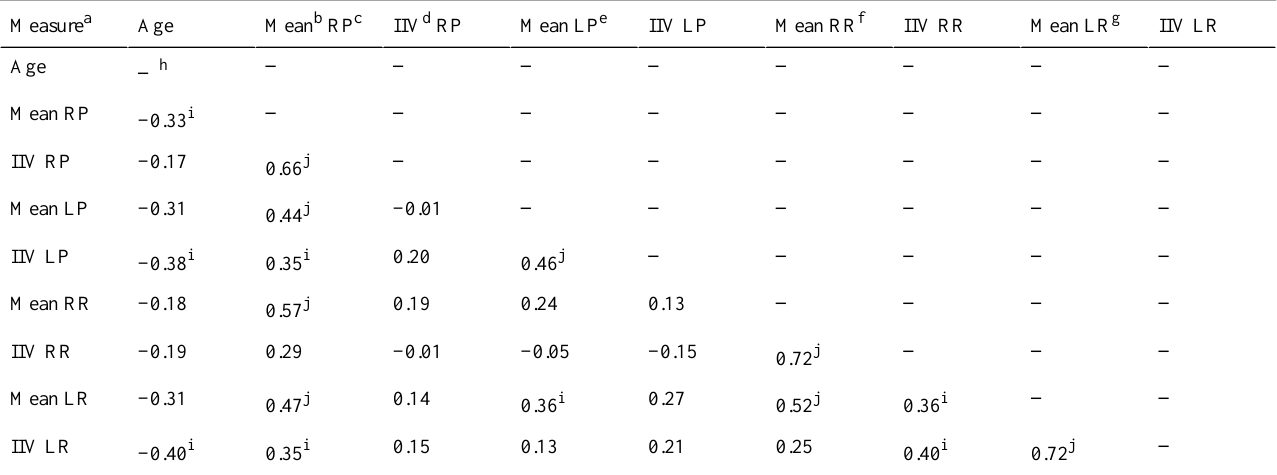
Table 1. Pearson correlations between age and placement and removal